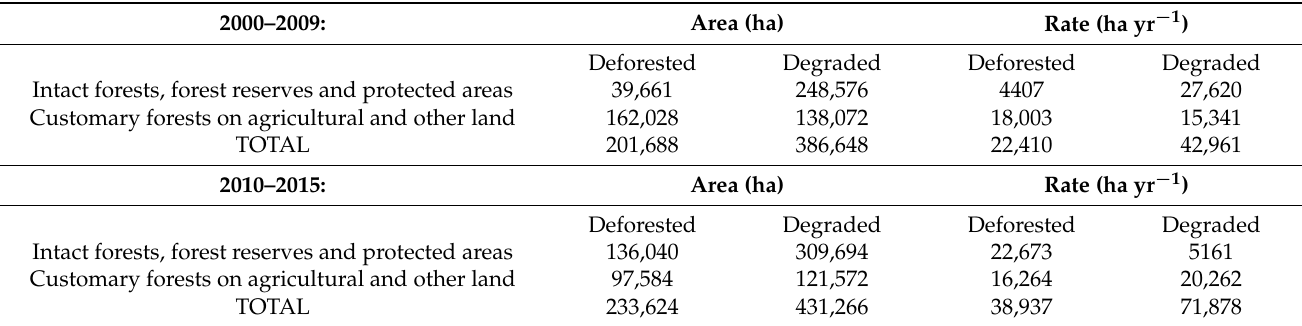
Table 3. Area estimates of deforestation and forest degradation in Malawi. Estimates are present for two time periods, 2000–2009 and 2010–2015, for both intact forests and forest reserves and forest land in agriculture and customary land. The total area deforested or degraded between time periods and the average annual rates in time periods are